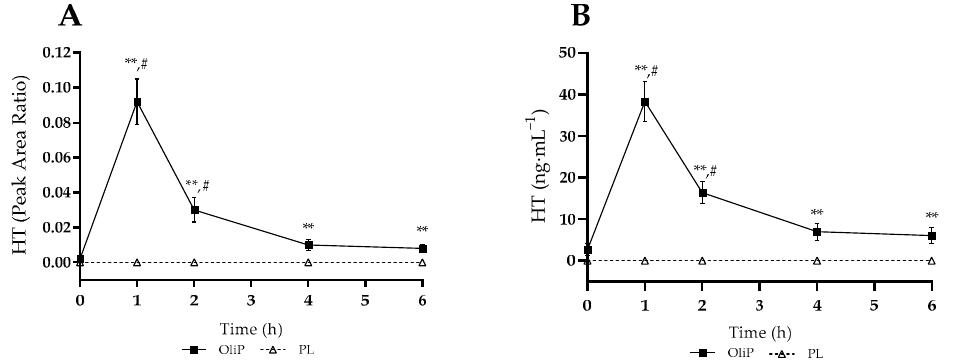
Figure 1. Plasma hydroxytyrosol (HT) responses following consumption of single serve of either Oliphenolia (OliP) or placebo (PL). ( A ) Instrument peak area ratio; ( B ) Converted HT concentration. ** denotes significant difference between conditions at timepoint ( p ≤ 0.009). # denotes significant difference within OliP compared to baseline ( p < 0.001).